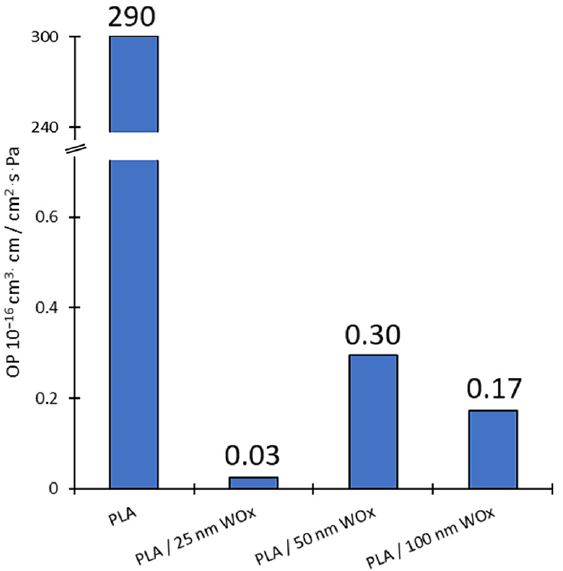
Figure 8. Permeability values to oxygen for PLA and the PLA/WO x samples.